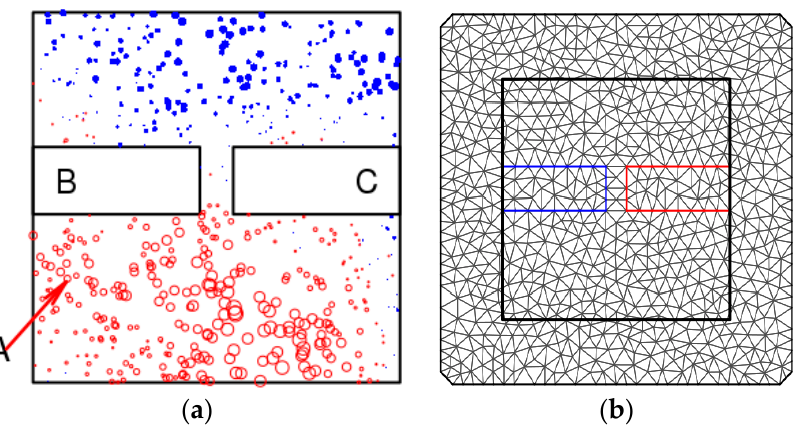
Figure 5. Simulated data: ( a ) Simulated research area and data points; ( b ) Triangular grid. Note: area A in ( a ) is the general area of interest, and areas B and C are two different types of obstacle